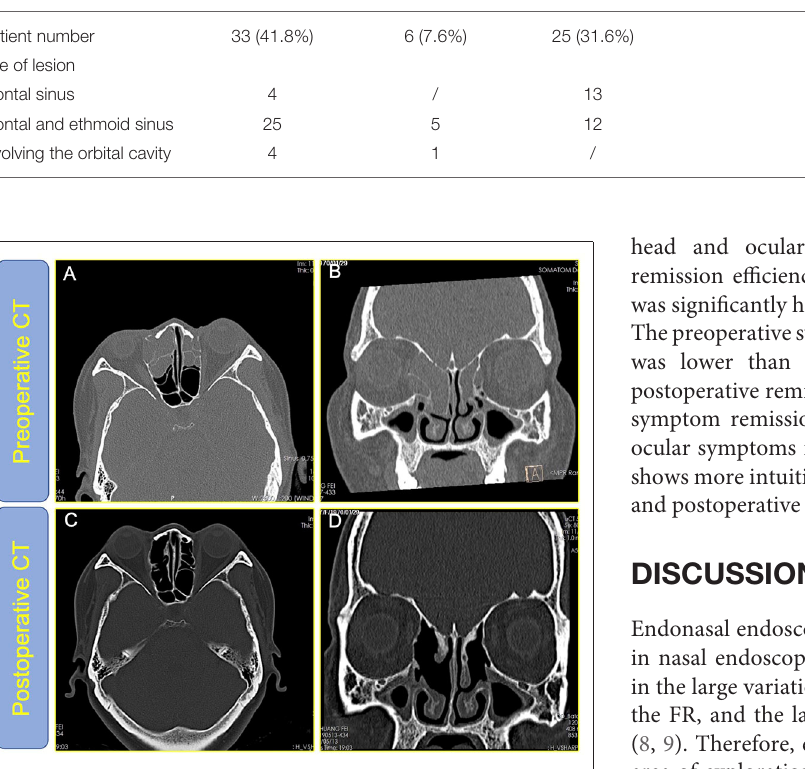
FIGURE 4 | (A,B) The high-resolution CT of the nasal sinuses of patient #70 before surgery; (C,D) The high-resolution CT of the nasal sinuses of patient #70 1 year after surgery showed that all diseased sinuses were open and the disease-free sinuses are undisturbed and the nasal mucosa is well